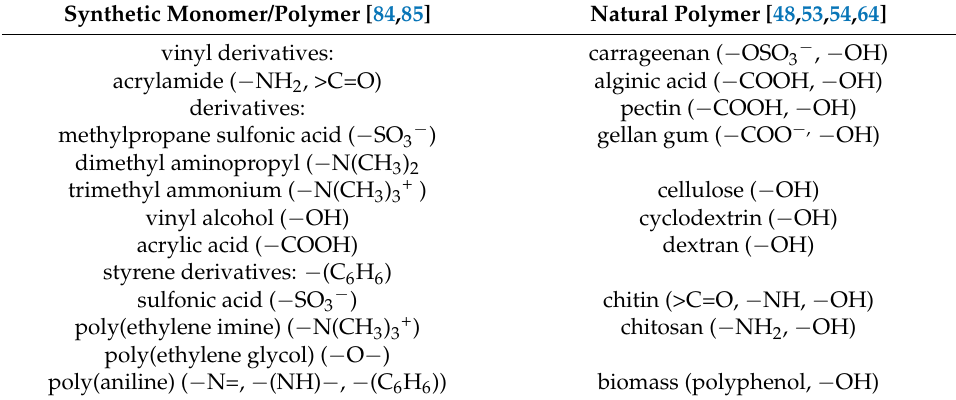
Table 1. Representative gel materials and involved functional groups. Synthetic Monomer/Polymer